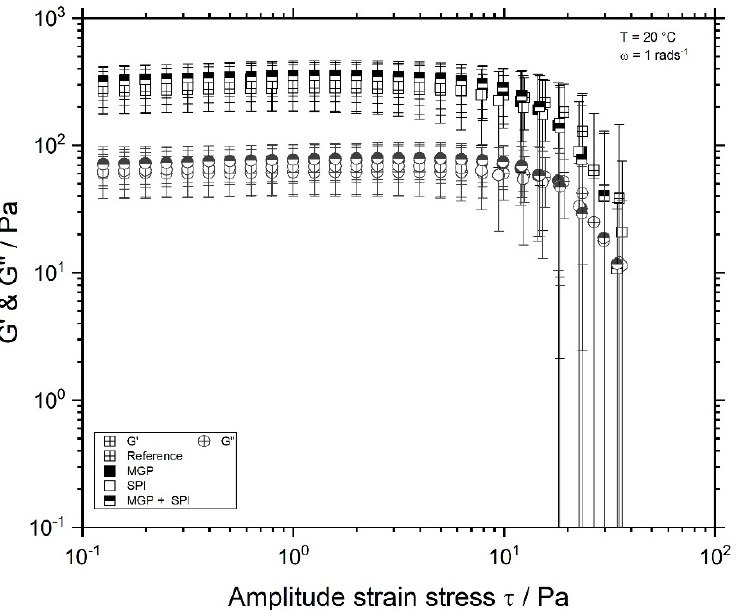
Foods 2022 , 11 , x FOR PEER REVIEW 7 of 16 the linear viscoelastic region (LVE) of SPI gels. Softer materials should sustain greater strain stress than densely packed materials [32]. The maximal stress within the LVE, 𝜏 (cid:3040)(cid:3028)(cid:3051) , is determined by the gel’s strength. An increase of stress strain beyond 𝜏 (cid:3040)(cid:3028)(cid:3051) leads to changes in the elastic and viscous behaviour of the samples [33]. The effect that the addition of fibre and fat has on the gel properties depends on the type and extent of the interactions between these components and SPI [34]. It was expected that the addition of fibre in form of microgel particles and fat would affect the length of the LVE of the SPI- gels compared to samples without these components [8,20,22]. However, as seen in Figure 2, amplitude tests show no difference between the samples.